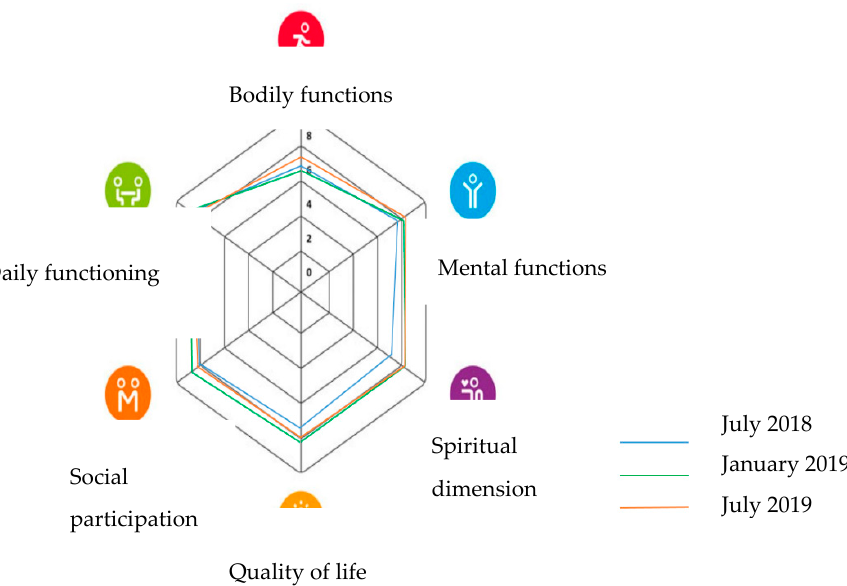
Figure 2. Subjectively rated positive health tool during the interviews with volunteers. Rated from 0 to 10, where each web line in the figure represents an increase of 2 points. In the middle, participants rated the domain with the lowest score 0, and at the edges, the score was 10, indicating that a larger web indicated a better positive health score.